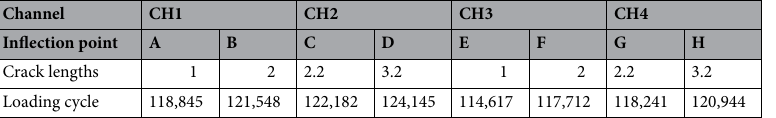
Table 8. Monitoring results in hygrothermal and ultraviolet radiation environmental